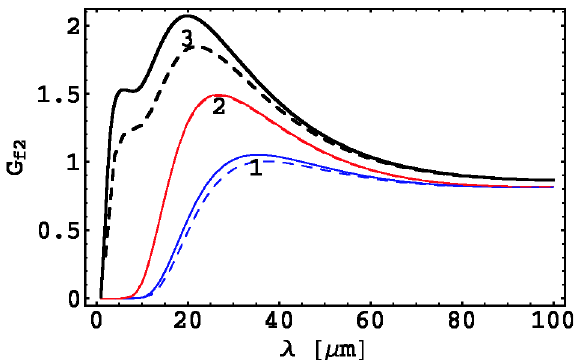
FIG. 3. (Color) BC2 gain G of density modulation as a function of modulation wavelength at the entrance of BC2 for f 2 (cid:3) 3 (cid:12) 10 (cid:4) 5 , (cid:18)" (cid:3) 1 (cid:20) m (blue); (2) (cid:16) (cid:3) 3 (cid:12) 10 (cid:4) 5 , (cid:18)" (cid:3) 0 (cid:20) m (red); and (3) (cid:16) (1) (cid:16) (cid:17) (cid:17) 0 0 Solid curves are calculated from Eq. (38), and dashed curves are numerical solutions of the integral equation obtained with the correct sign of R 56